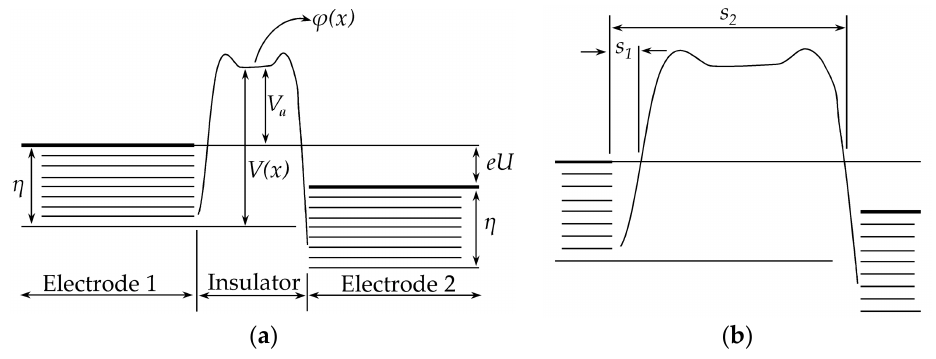
Figure A1. Band diagram of a thin insulating film sandwiched between to metal electrodes. ( a ) Description of the band diagram depicting electrical variables; ( b ) Zoom-in around the insulator depicting the width of the potential barrier.